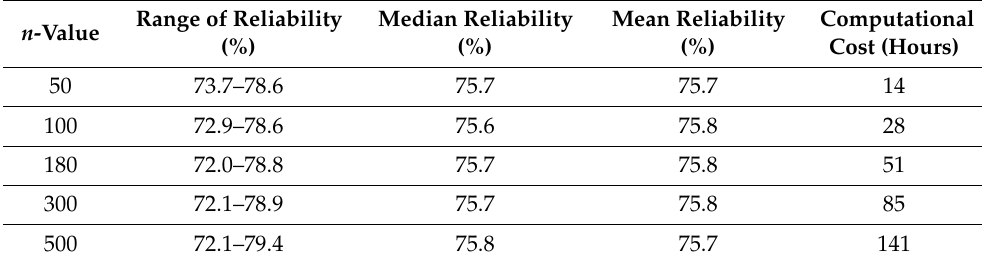
Table 4. Difference in the range of water supply reliability over 10-year timeframe generated by the number of combinations of water, sediment inflows and water demands ( n